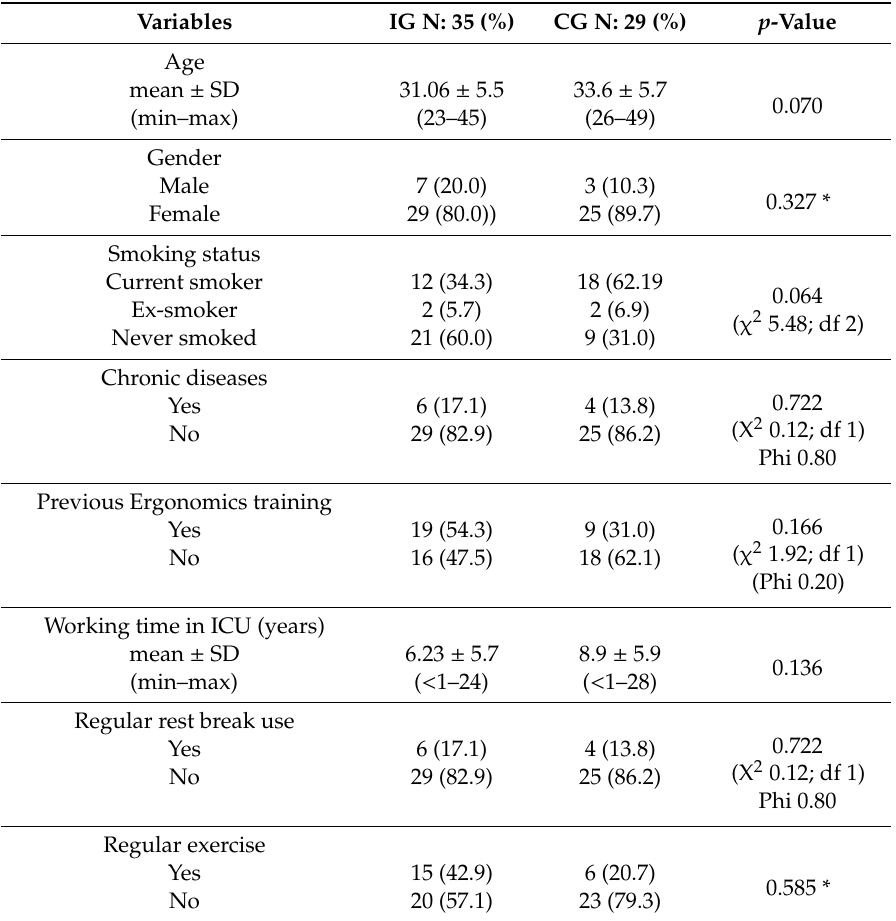
Table 1. Basic characteristics of the study